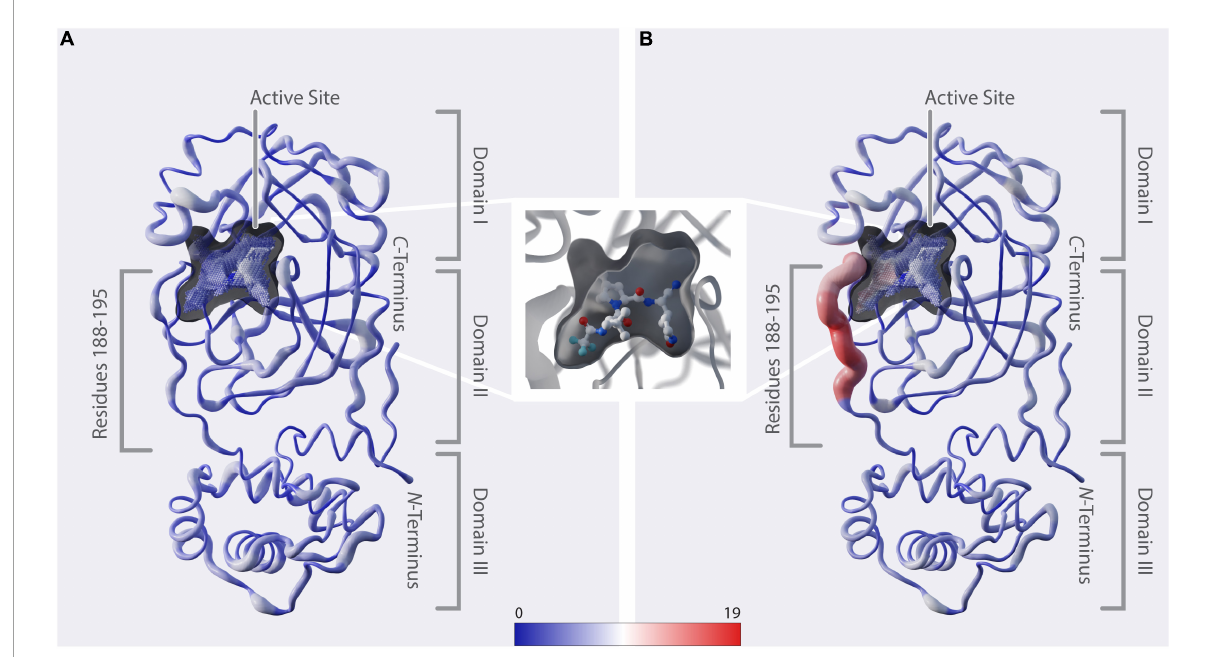
FIGURE3 Structural representation of mutation dynamics. (A) Structure of M pro [PDB entry 7SI9 (43)] represented as a putty figure showing the cumulative number of unique amino-acid exchanges along the protein sequence including sequences collected before 1 December 2021, referring to Figure 2A (#uaae). The active-site cavity is colored by the number of unique amino-acid exchanges of its surrounding residues (color bar). (B) As in panel (A) but including only sequences collected starting from 1 December 2021, referring to Figure 2B (#uaae). (In between panels A, B ) Zoom in on the active-site cavity, including the inhibitor nirmatrelvir [PDB 7SI9 (43)]. Additionally, we provide a movie in the Supplementary Movie 1 , showing the cumulative unique amino-acid exchanges per day from 24 December 2019 to 22 June